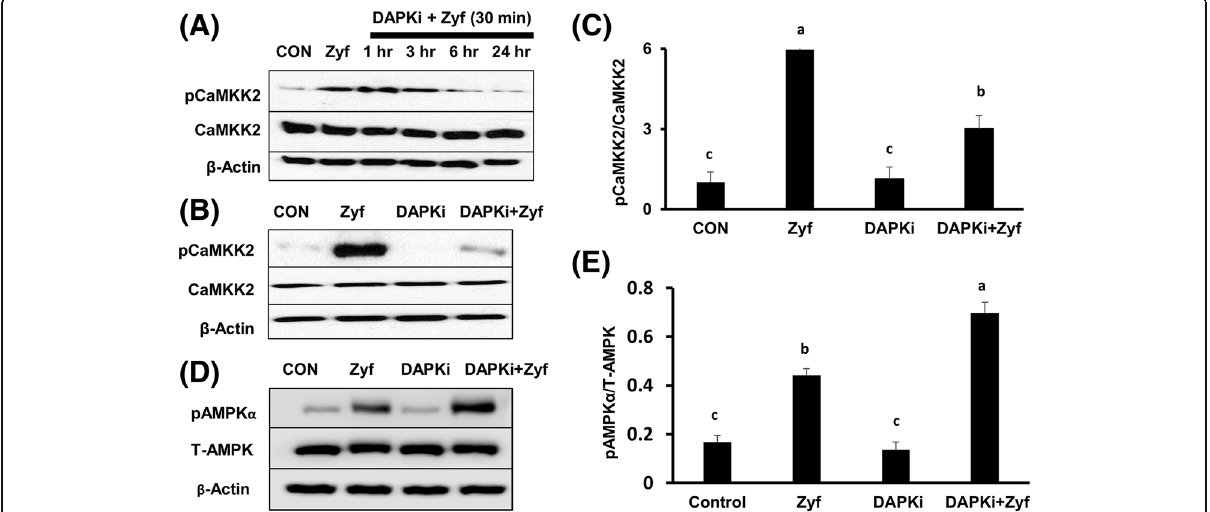
Fig. 4 The effects of Zyflamend and an inhibitor of DAPK on the phosphorylation of CaMKK2 (at Ser511), in CWR22Rv1 cells. A Western blot of pCaMKK2 ± Zyflamend (200 μ g/mL, 30 min) and following treatment of DAPKi (20 μ M, 1 h – 24 h) followed by the treatment of Zyflamend (200 μ g/mL, 30 min). B , C Western blot and graph comparison of pCaMKK2 following treatment of DAPKi (20 μ M, 24 h) ± Zyflamend (200 μ g/mL, 30 min). ( D , E ) Western blot and graph comparison of pAMPK following treatment of Zyflamend (200 μ g/mL, 30 min) and DAPKi (20 μ M, 24 h) ± Zyflamend (200 μ g/mL, 30 min). Data are presented as mean ± SEM, n = 3. Bars with different letters are statistically different at p <